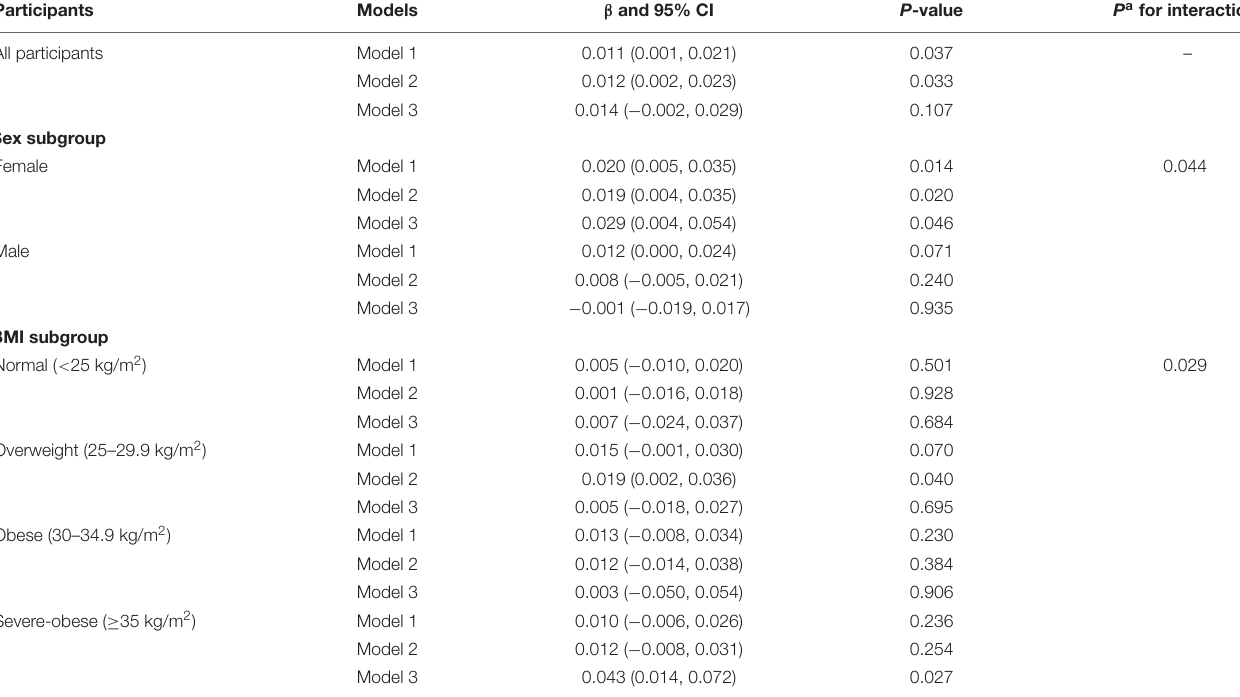
TABLE 2 | The association between riboflavin intake and telomere length among all/subgroup participants. Participants Models β and 95% CI P -value P a for interaction